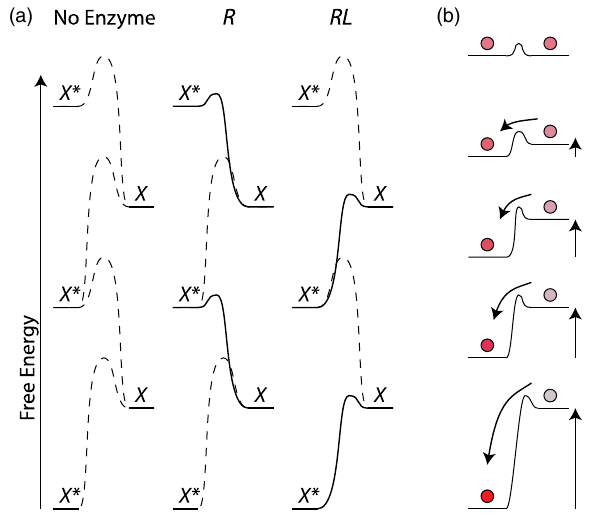
FIG. 3. Schematic comparison between the (free-)energy land- scapes of the biochemical network (a) and a thermodynamically optimal protocol (b). In (a), a ladder of states exists, with successive rungs related by the turnover of a single ATP (implicit in this figure, explicit in Fig. 1). In the absence of an enzyme, all transitions are slow (indicated by the dashed free-energy barrier connecting the states). In the presence of R , half of the transitions are catalyzed and can occur rapidly (solid lines); when exposed to RL , the alternative transitions are rapid. The heights of the rungs, however, are fixed, meaning that all transitions involve a fixed amount of chemical work equal to the offset. By contrast, for the optimal protocol in (b), switching between states is driven by slowly destabilizing one state with respect to the other, so that the majority of transitions have already occurred before the offset approaches its limiting